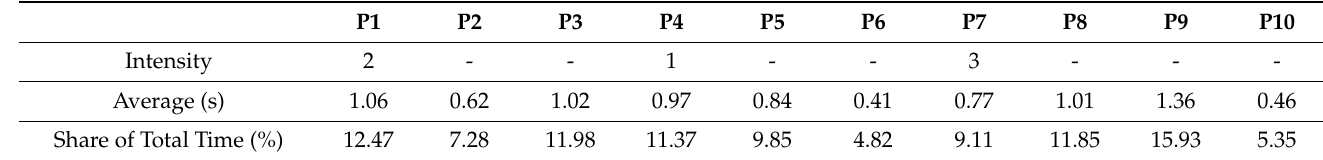
Table 4. Fixation times in the second product category with shadow highlights. Source: own elaboration.